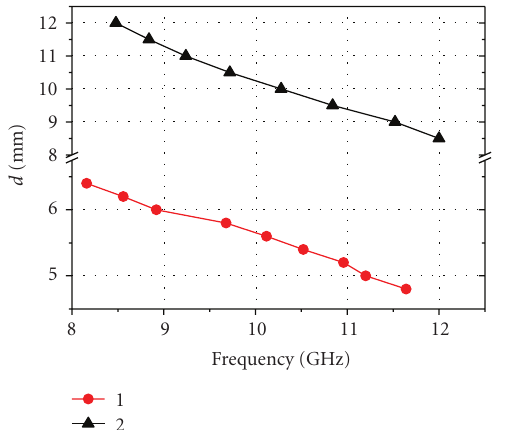
Figure 6: The dependence of the loaded Q-factor on the slot width: (1) a = 9mm, b = 15mm, d = 5 . 5 mm, ε 1 = ε 2 = 1; (2) a = d = 9 mm, b = 15 mm, ε 1 = 1, ε 2 = 3 . 78.